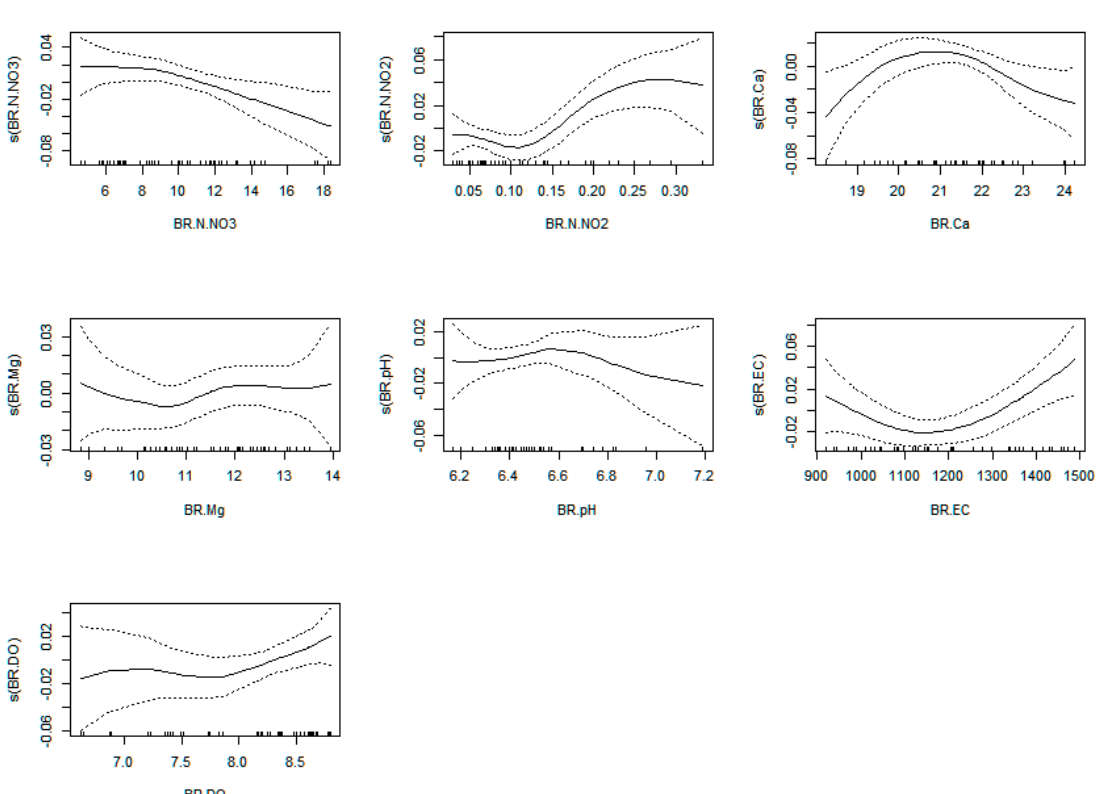
Figure A17. The GAM predictors influence over N-NH 4 for BR experimental variant.